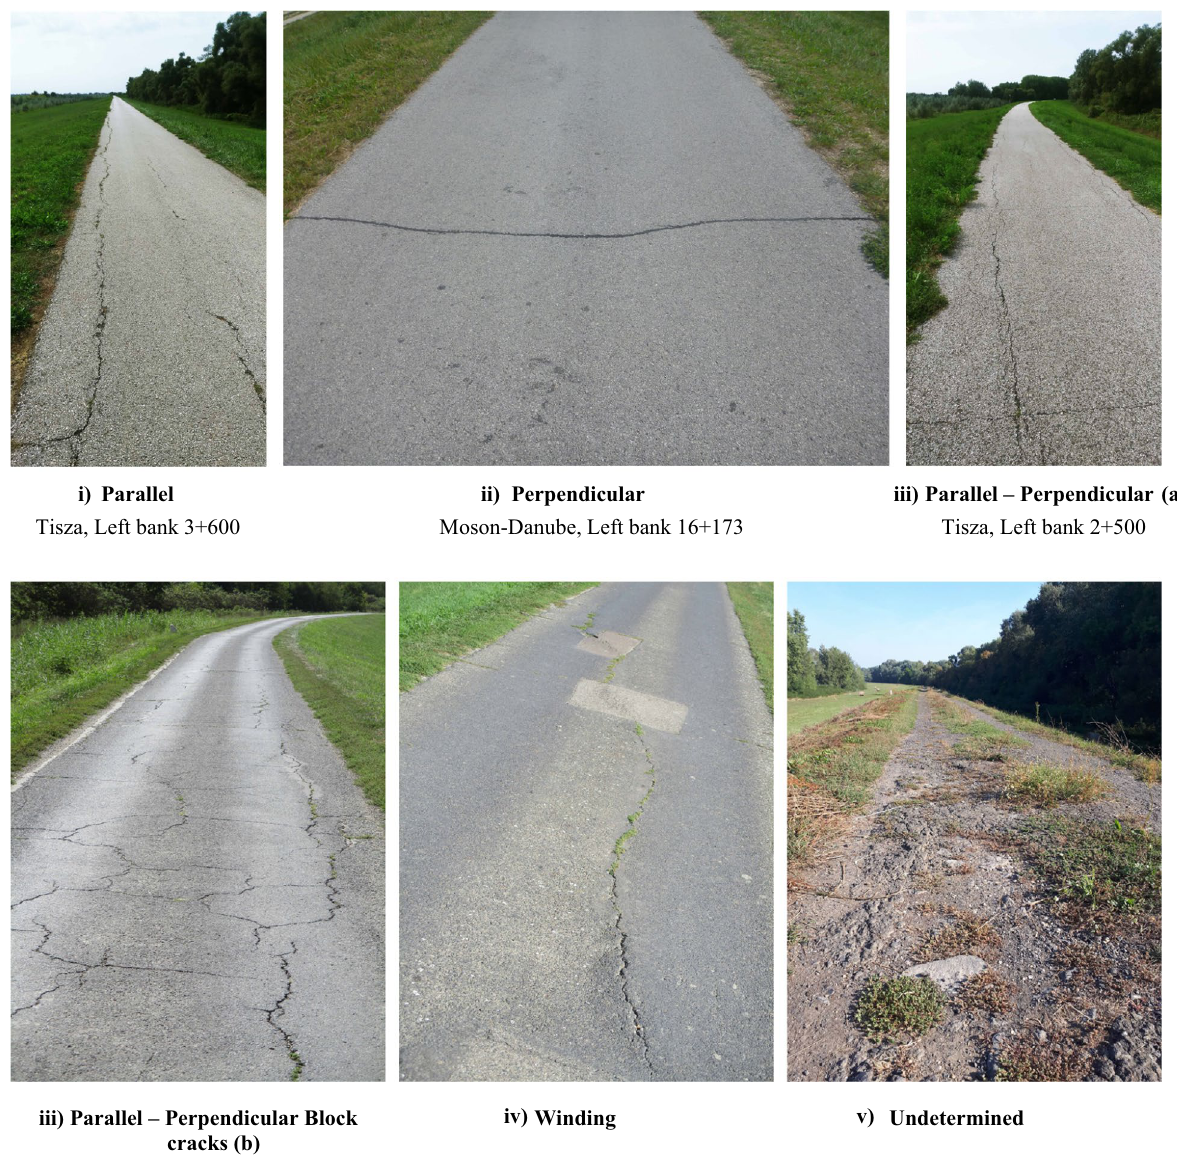
Fig. 4 Crack direction compared to the axis of the